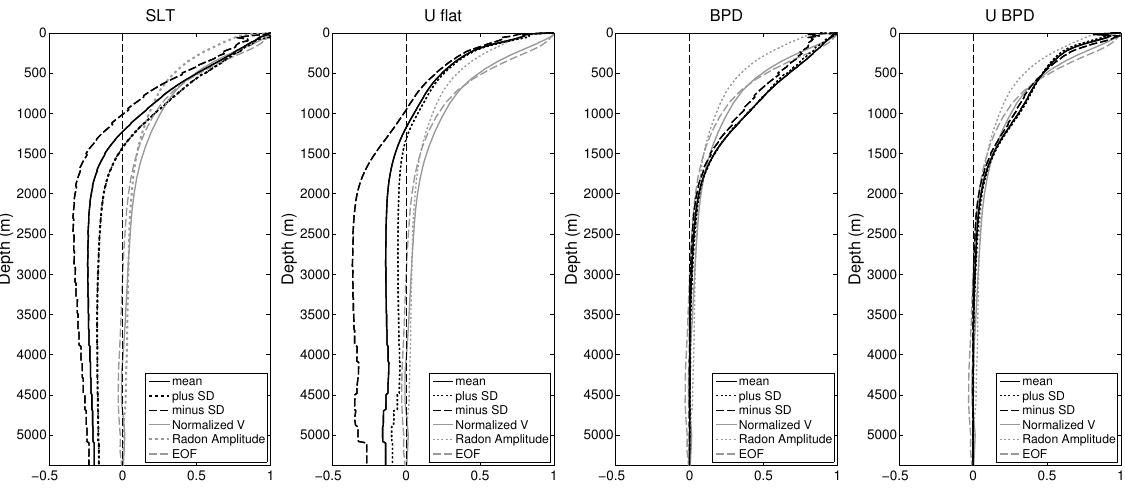
Fig. 6. Theoretical vertical profiles with their normalized ± 1 standard deviation (SD) profiles (black curves). (a) Standard linear theory, (b) mean flow with a flat bottom, (c) no mean flow with topography and (d) mean flow and topography. The grey lines are the same in each panel and show the model profiles for the 3 methods as a